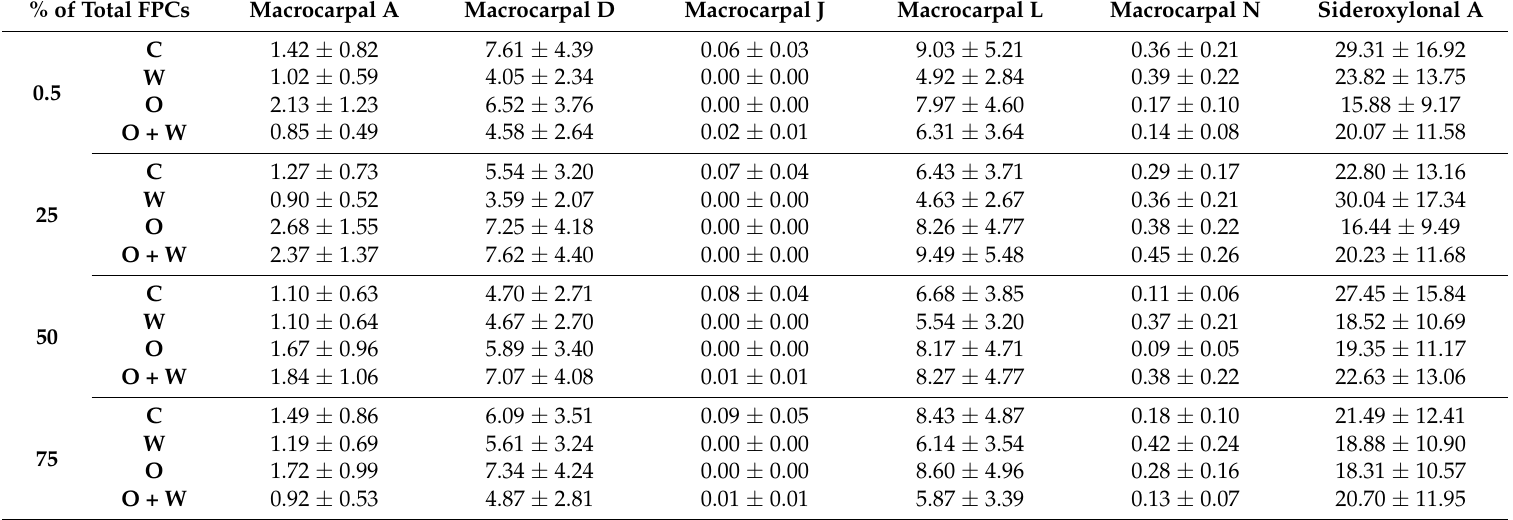
Table 5. Effects of treatments (control, wounding, O 3 , O 3 and wounding treatments) on the ratio of each individual FPC to the total FPCs in E. globulus leaves. Data shown are means ± SE ( n = 3). Details of the statistical summary are shown in Table 4. C, control; W, wounding; O, O 3 and O + W, O 3 +